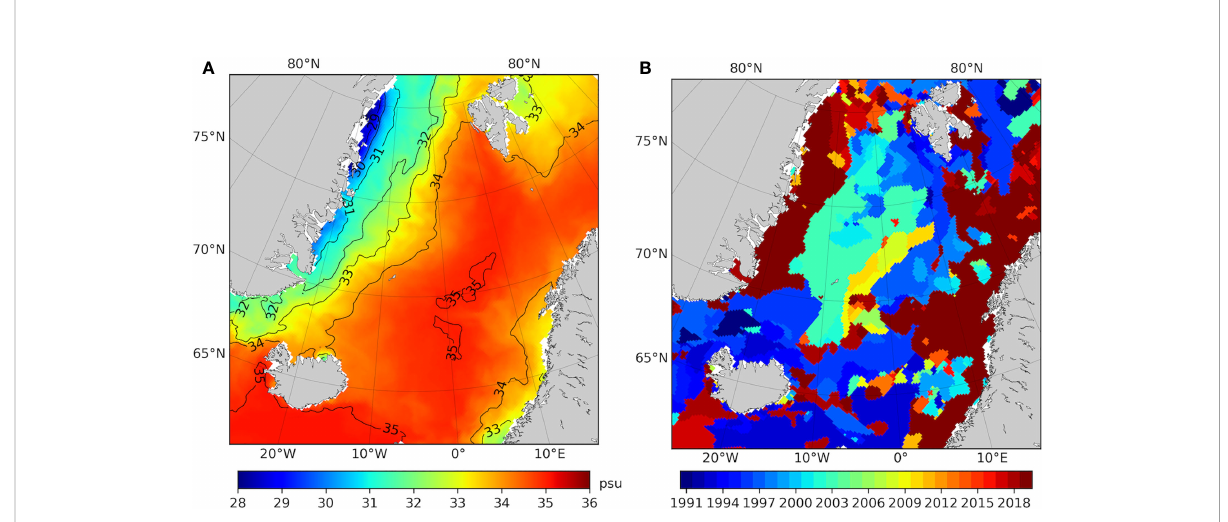
FIGURE 12 Spatial distribution of (A) minimum near-surface salinity for the period 1991-2019 and (B) the years in which the minimum salinity